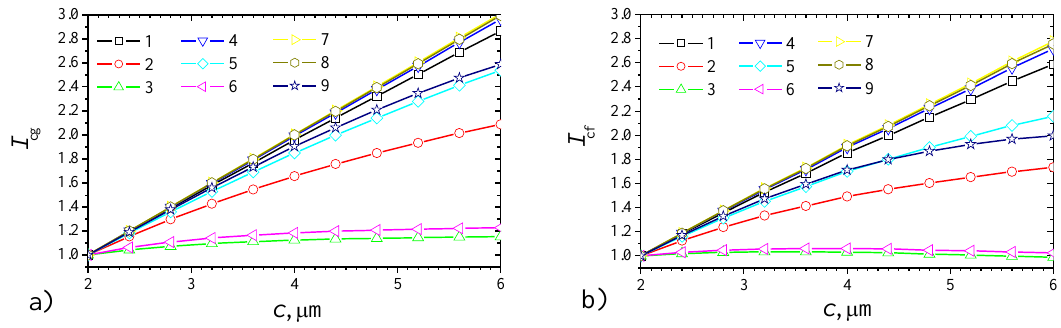
Figure 8 . The normalized steady state current vs. the gap depth c of the plate − gap biosensor (a) and the thickness of enzyme layer of the flat one (b), δ = 2 µ m. Other parameters and the notations are the same as in Fig.